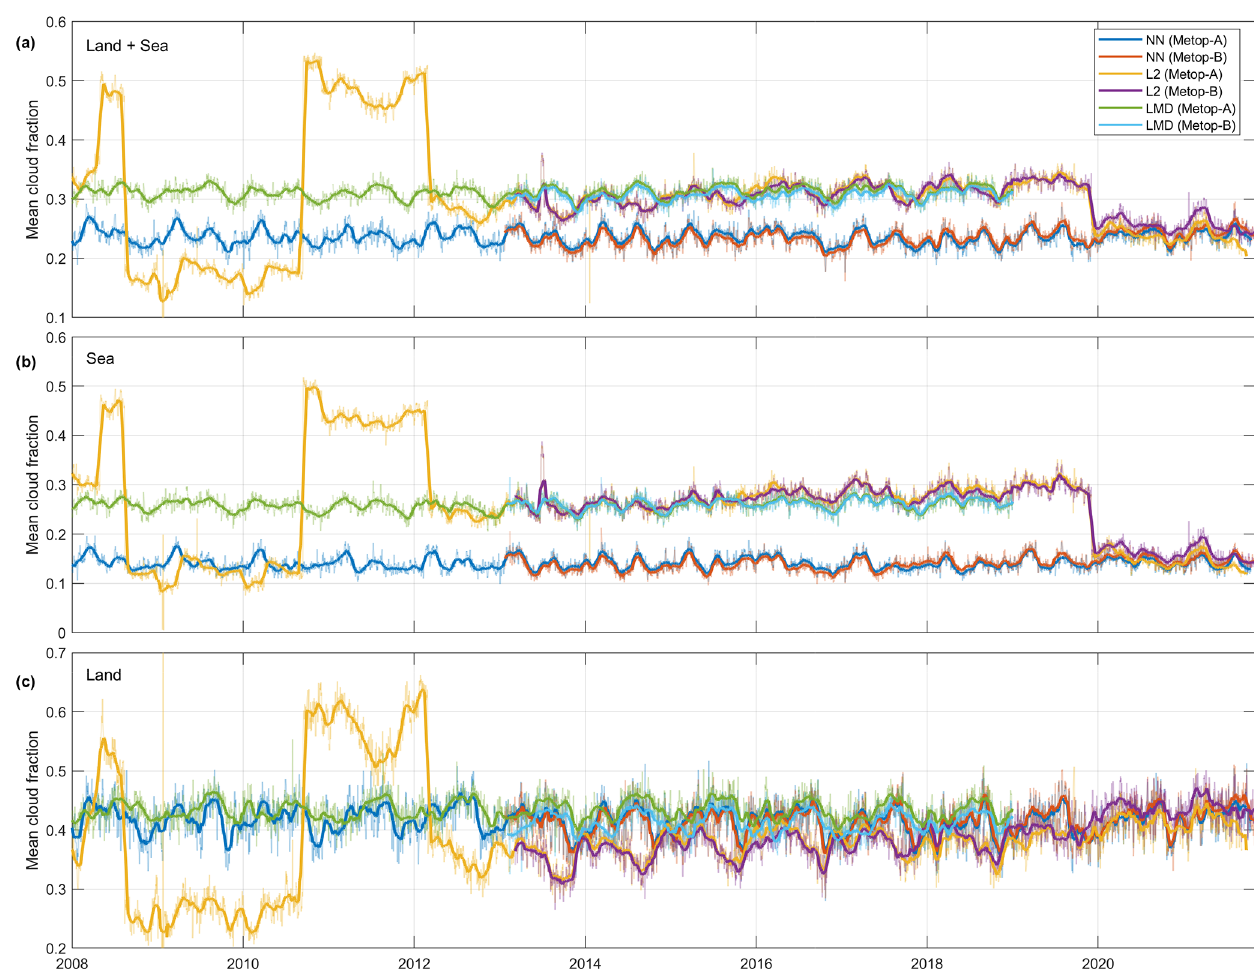
Figure 6. Time series of the daily mean fraction of cloud-free scenes for the L2, NN and LMD cloud products (Metop-A and Metop-B) globally for land and sea (a) and for sea (b) and land (c) observations only. The thick lines represent the 30d moving